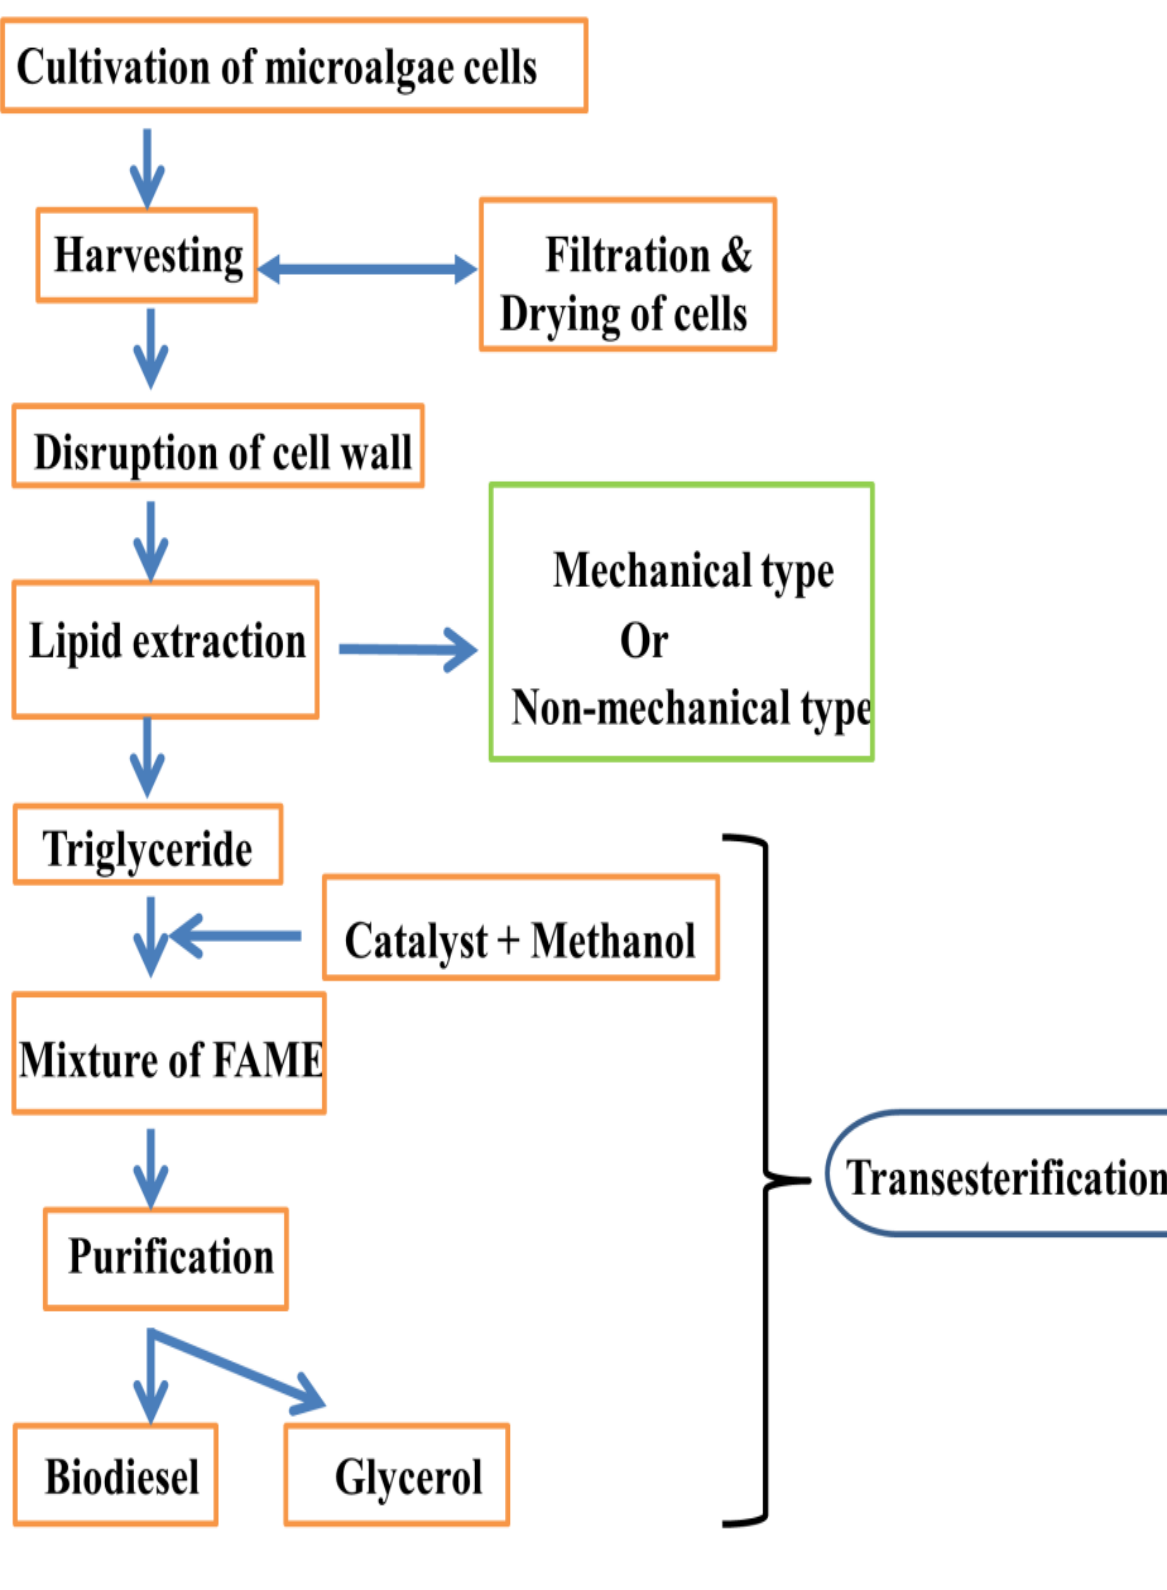
Figure 1. Flowchart diagram for biodiesel production through use of